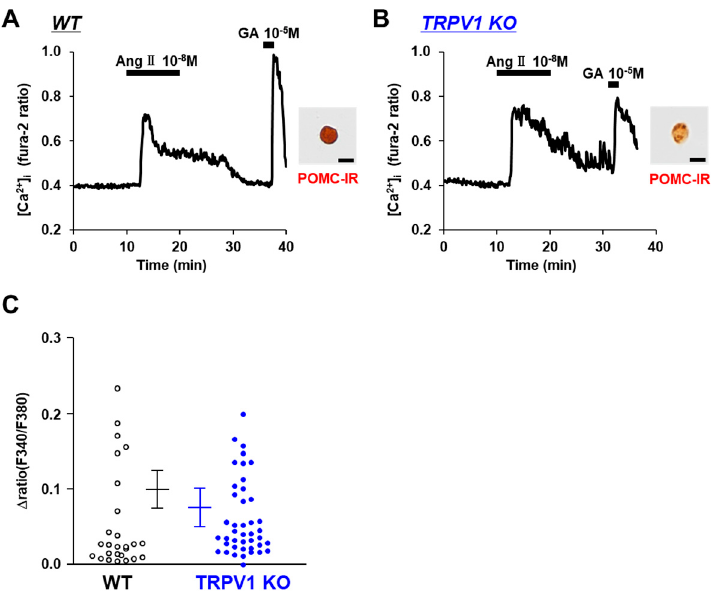
Figure 6. Angiotensin II increased [Ca 2+ ] i in single POMC neurons. ( A , B ) Angiotensin II increased [Ca 2+ ] i in single POMC neurons from wild-type (WT) mice ( A ) and Trpv1 KO mice ( B ). Scale bar is 20 μ m. ( C ) Average amplitude of [Ca 2+ ] i responses to angiotensin II ( Δ ratio) in POMC neurons. Data are presented as mean ± SEM. WT vs. KO determined by one-way ANOVA followed by the Bonferroni test.